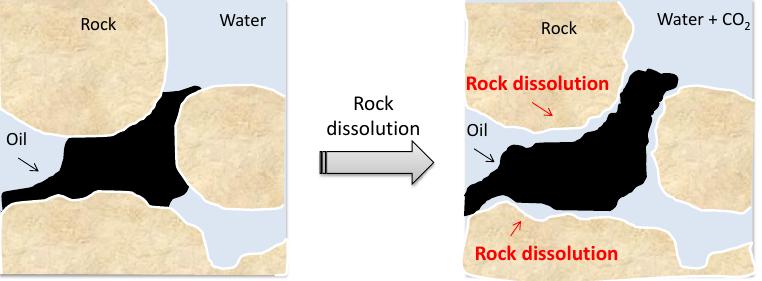
Figure 10. Schematic diagram of rock dissolution due to carbonated water in situ and oil detach- ment.